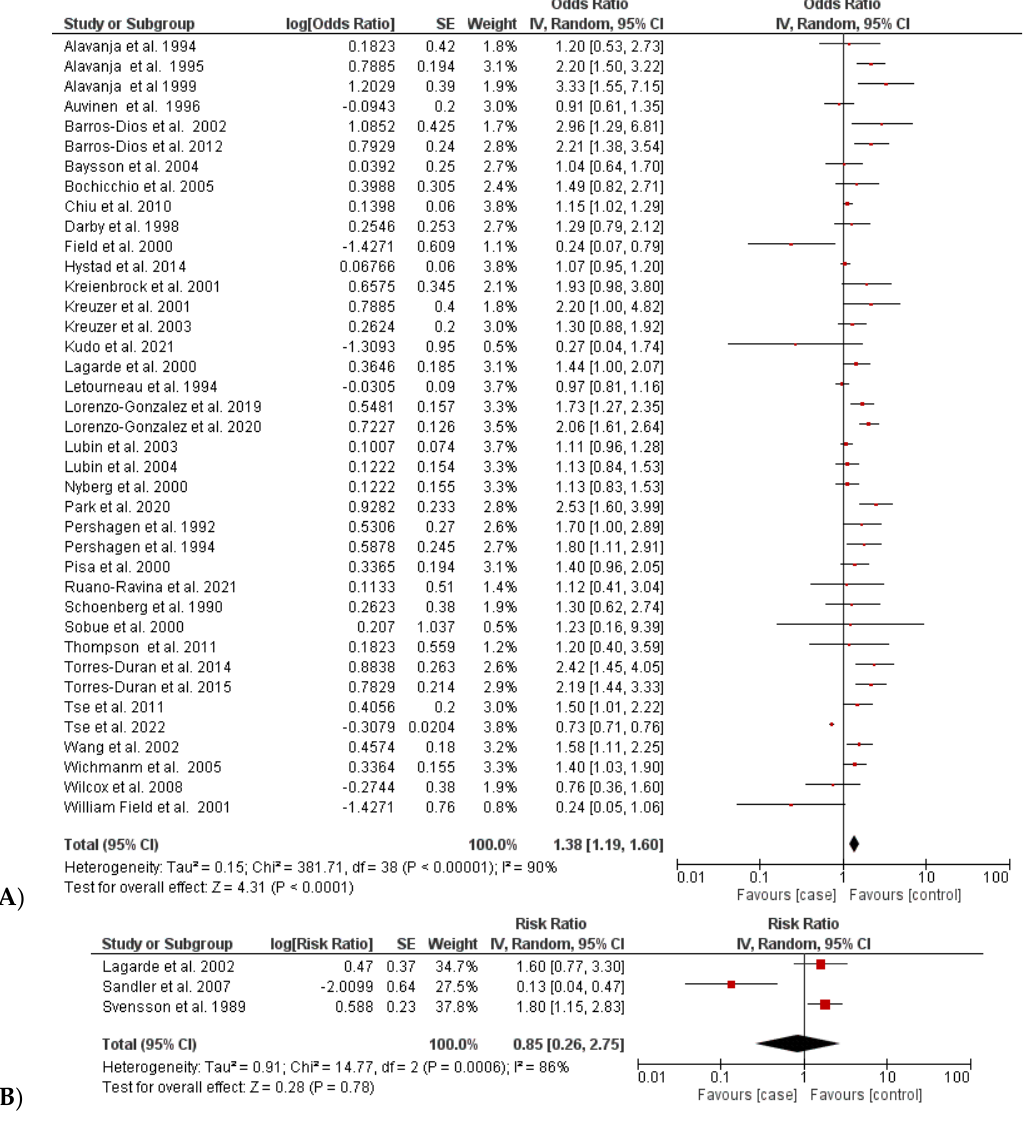
Figure 2. Comparison of incidence of radon-caused lung cancer between case and control groups: ( A ) analysis based on OR values [4,5,13 – 15,21 – 26,29,34 – 50,52,53,55 – 62] and ( B ) analysis based on RR values [27,51,54]. ( B ) Red color: OR/RR values of individual studies, Black color: pooled OR/RR of the comparison.